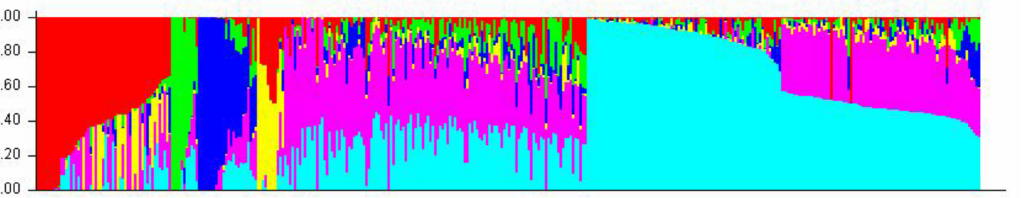
Figure 6. Population structure of 384 maize inbred lines based on 60,227 polymorphic SNPs at K = 6. Each inbred line is represented by a vertical line that is partitioned into K-colored segments, with lengths proportional to the estimated probability membership value (y-axis). The six groups are shown in different colors: G1 (Green), G2 (Pink), G3 (Yellow), G4 (Red), G5 (Blue), and G6 (Cyan). See Table S4 for details on group membership.